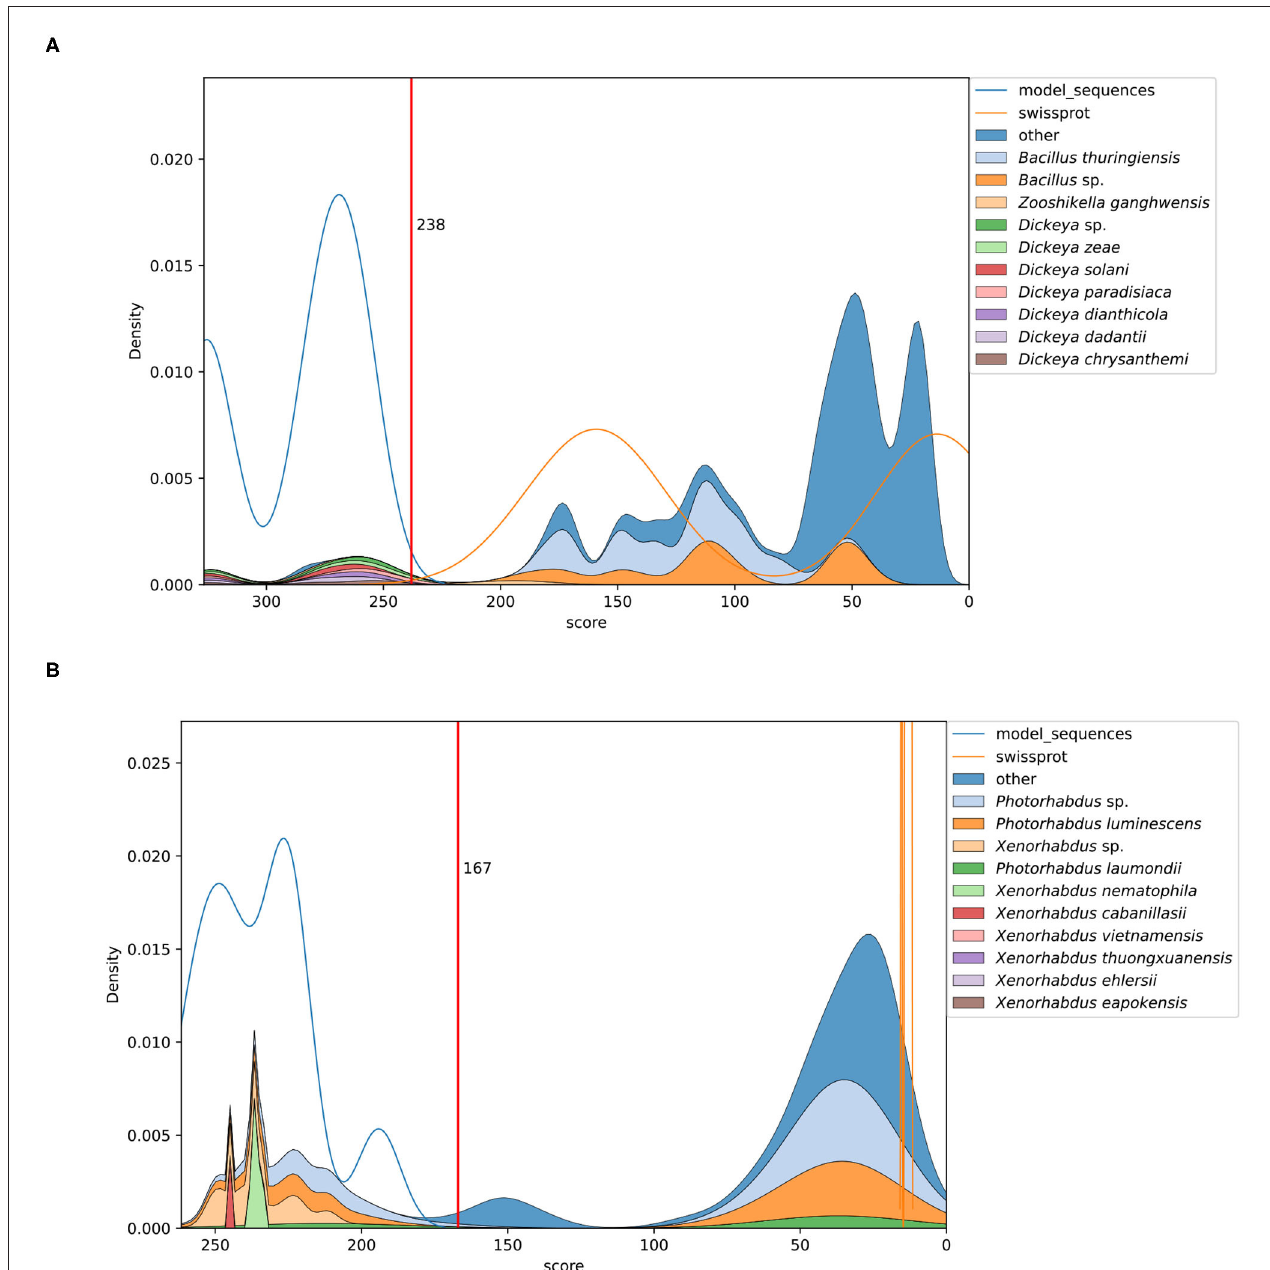
FIGURE 1 | Kernel density plots depicting distribution of model matches in UniProtKb. (A) The profile HMM identifies Cyt 4/5/6/7 proteins from Dickeya spp. within the high score range. The red line marks the curated gathering cutoff. Matches scoring below 238 correspond to related Cyt proteins from other source organisms. (B) A model targeting Pra sequences produced by Photorhabdus spp. and Xenorhabdus spp. Some Yersinia spp. proteins score directly next to the gathering